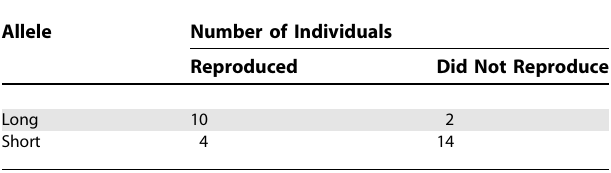
Table 2. Reproductive Ability Following Heat Stress of Aphids Derived from the Same Clonal Lineage, 5A, with Alternative Buchnera ibpA Heat-Shock Promoter Alleles Allele